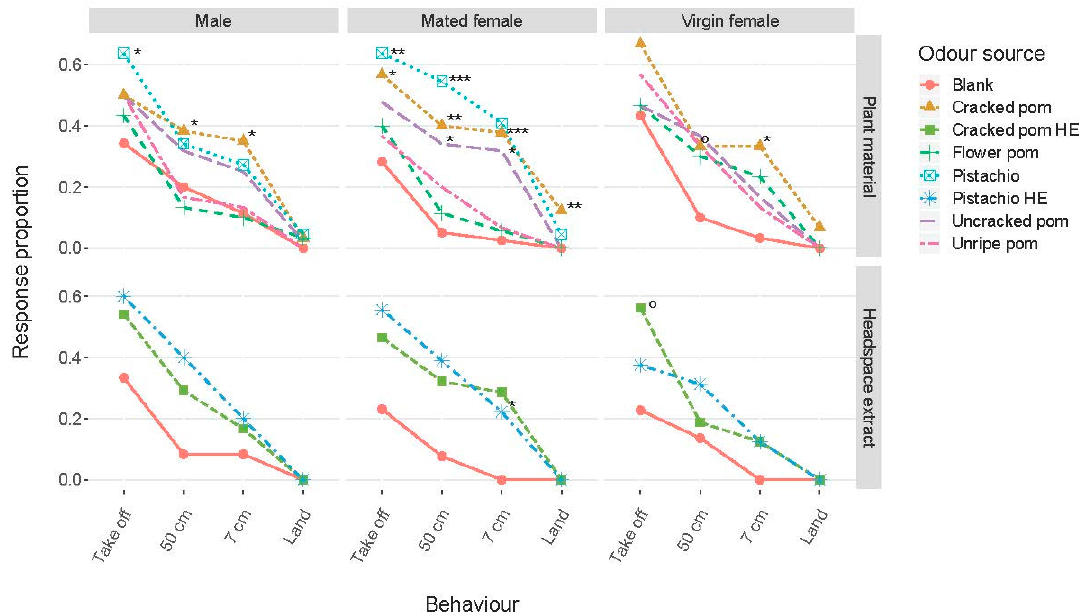
Figure 2. Behavioral responses of mated female and virgin female and male carob moths to a series of plant materials (pomegranate and pistachio) and their headspace extracts (HE) in wind tunnel bioassays. Differences between the odor sources and controls at each behavioral step are depicted using the following codes: *** p ≤ 0.001, ** p ≤ 0.01, * p ≤ 0.05, ° p ≤ 0.1.